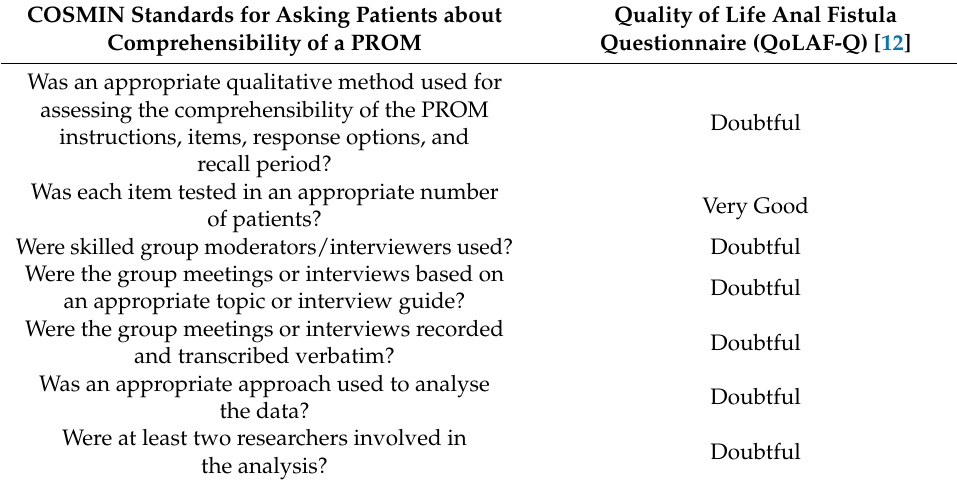
Table 2. Asking patients about the comprehensibility of the QoLAF-Q. COSMIN Standards for Asking Patients